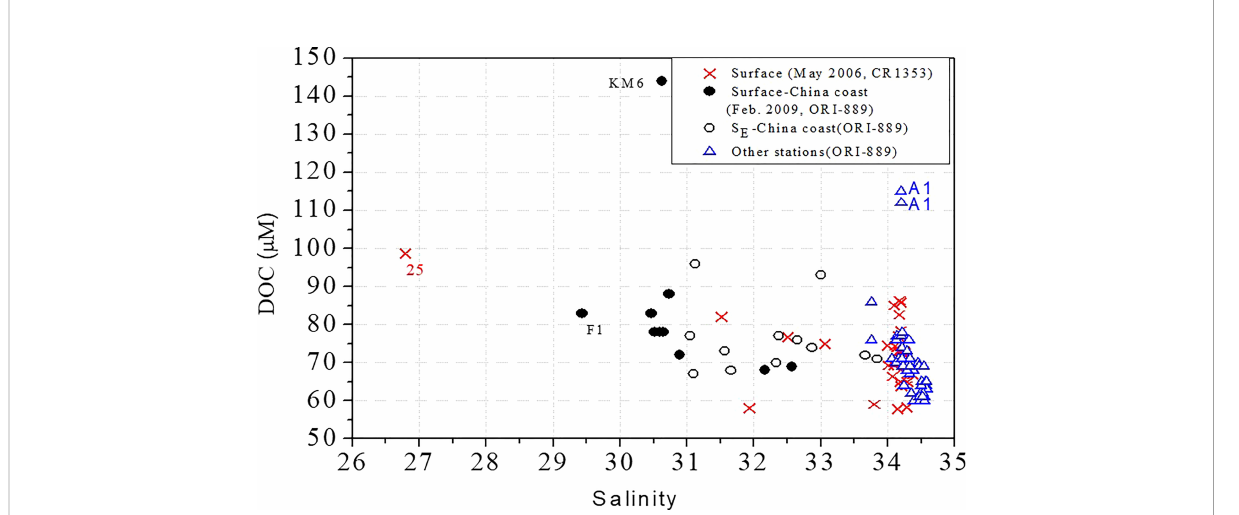
FIGURE 11 Relationship between DOC and salinity in early summer ( × , CR1353) and winter (other icons, CR889) in the TS. S E -China coast is surface-excluded samples in the coast of China. The sampling stations with particularly low salinity and high DOC concentrations (25, F1, KM6, A1) are